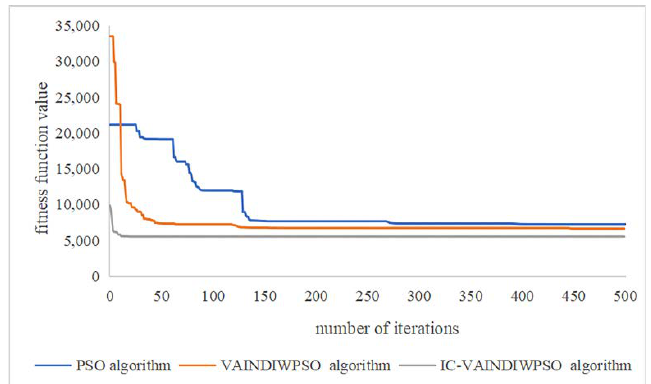
Figure 6. Top view of the path generated by the IC-VAINDIWPSO algorithm.